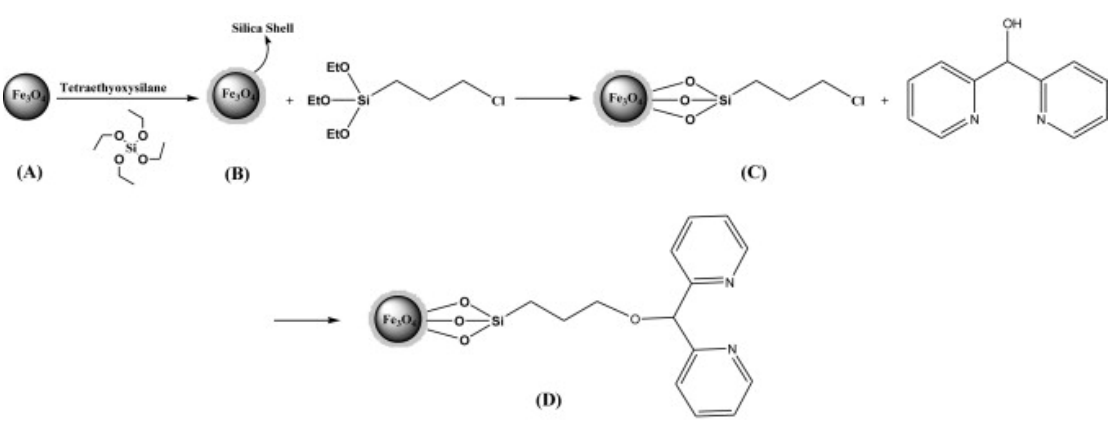
Figure 5. Sequence of the synthesis of Fe O /Dipyridine: showing the original magnetic 3 4 nanoparticle ( A ), the nanoparticle after attachment of a silica shell with TEOS ( B ), after the attachment of 3-chloropropyltriethoxysilane to form the organic linker ( C ), and the addition of methylene di-pyridine catalyst species ( D ). Reproduced from Nasseri et al. [60]. Copyright 2013 with permission of